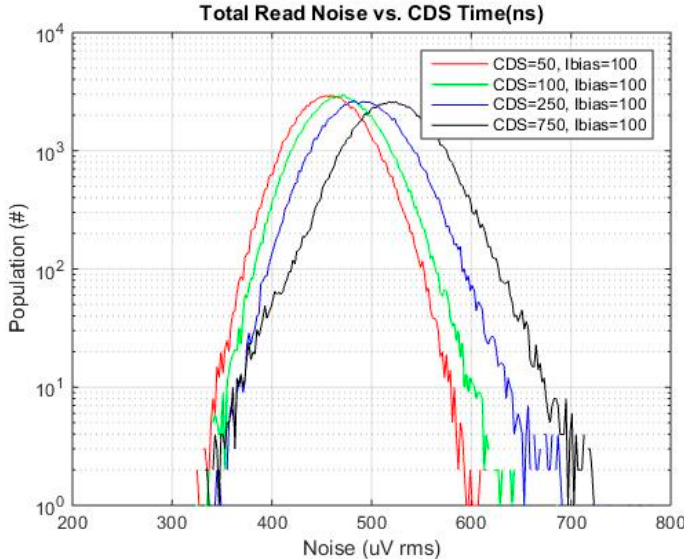
Figure 10. Total read noise for each t CDS and SF Ibias of 8 μ A (100 μ A master current).